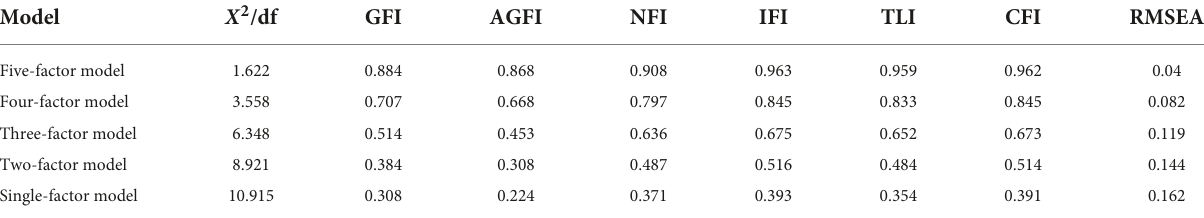
TABLE 2 Results for confirmatory factor